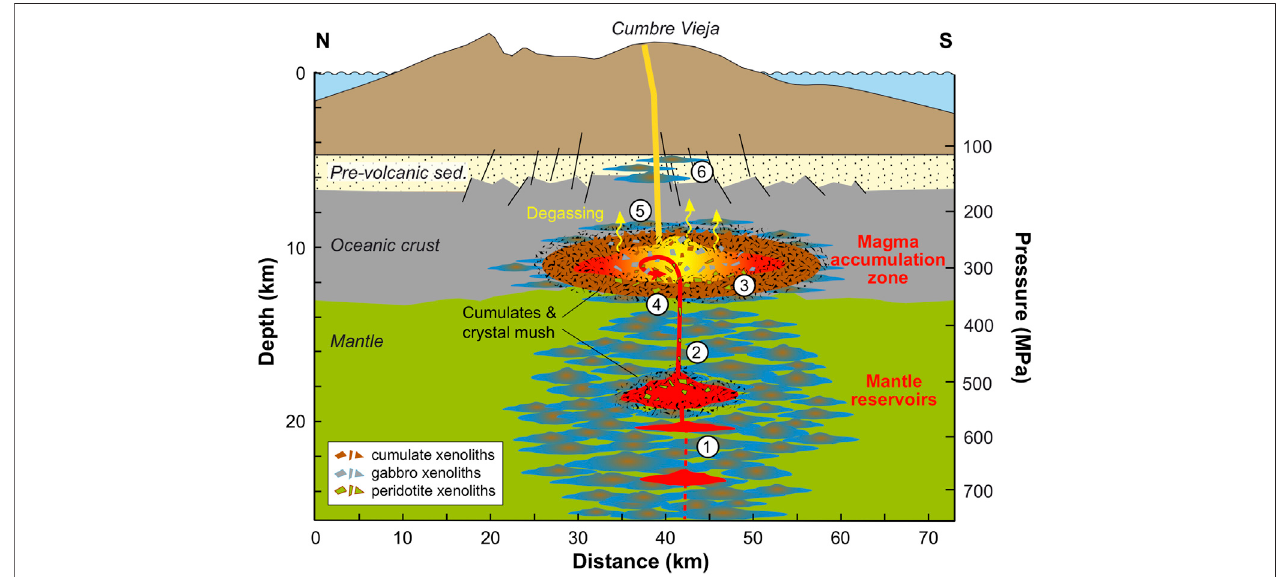
FIGURE 11 | Sketch for phonolite formation beneath La Palma. Magma reservoirs are not to scale but are enlarged to improve clarity; former melt pockets now cooled are drawn in blue, the active system in red to yellow. (1) Magmas rising from depth accumulate and fractionate to various degrees in upper mantle reservoirs. Some phonolite can form in smallpockets. (2) Periodically, a reservoir rupturesand a batch ofmagma rises into the accumulation zone in the lower crust, in some cases carryingperidotitefragments.Themagmaemplacementmayormaynotleadtoaneruption.(3)Magmaintheaccumulationzonecontinuestocoolandfractionates towards phonolite. Peridotite xenoliths react with the evolved melts and become deposited in a crystal mush. Further recharge pulses bring new magma from mantle depths.(4)A fi nalrechargeeventdestabilizesthemagmaaccumulationzone,causingruptureofthema fi ccrystalcarapaceandofgabbroicwall-rock,andminglingofthe xenolith suite. (5) Possibly triggered by overpressurization, the tephriphonolite rises to the surface. (6) Short-term ponding in the upper crust may be possible, but is not re fl ected by our barometric data.